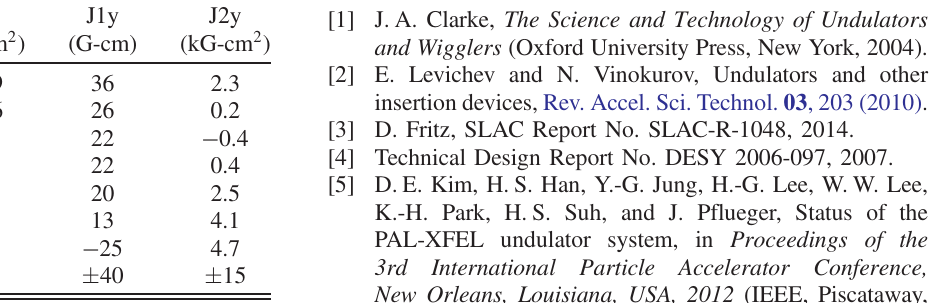
TABLE IV. LCLS-II field integrals. Gap, mm